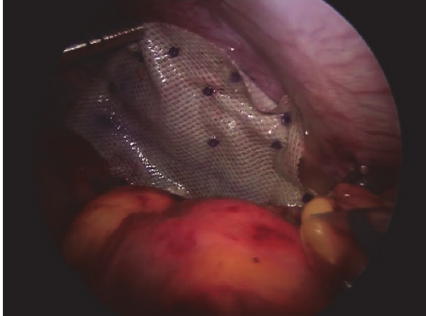
Figure 4: CT scan showing stomach herniation in left Bochdalek hernia.